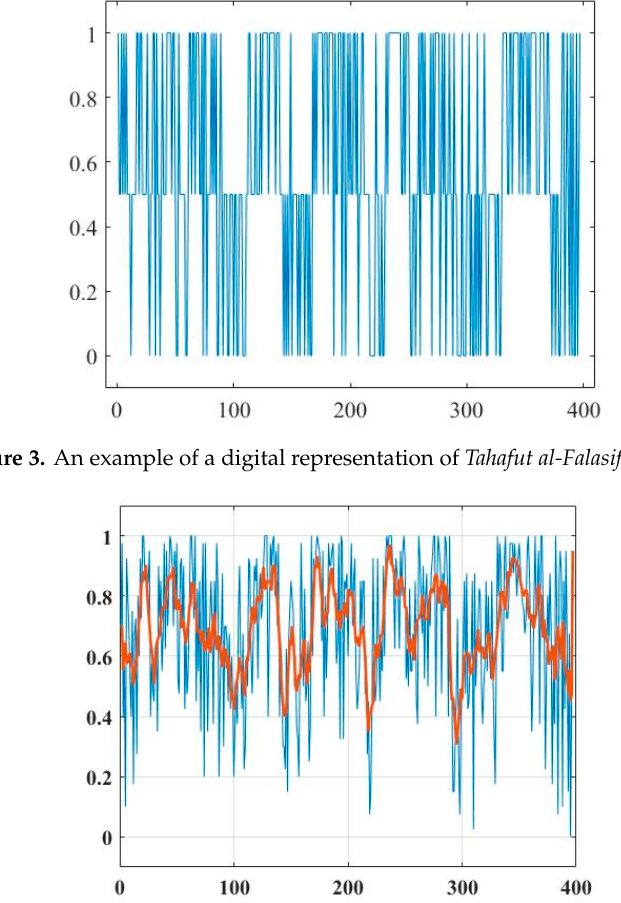
Figure 4. A digitally averaged representation of Tahafut al-Falasifa chunks.